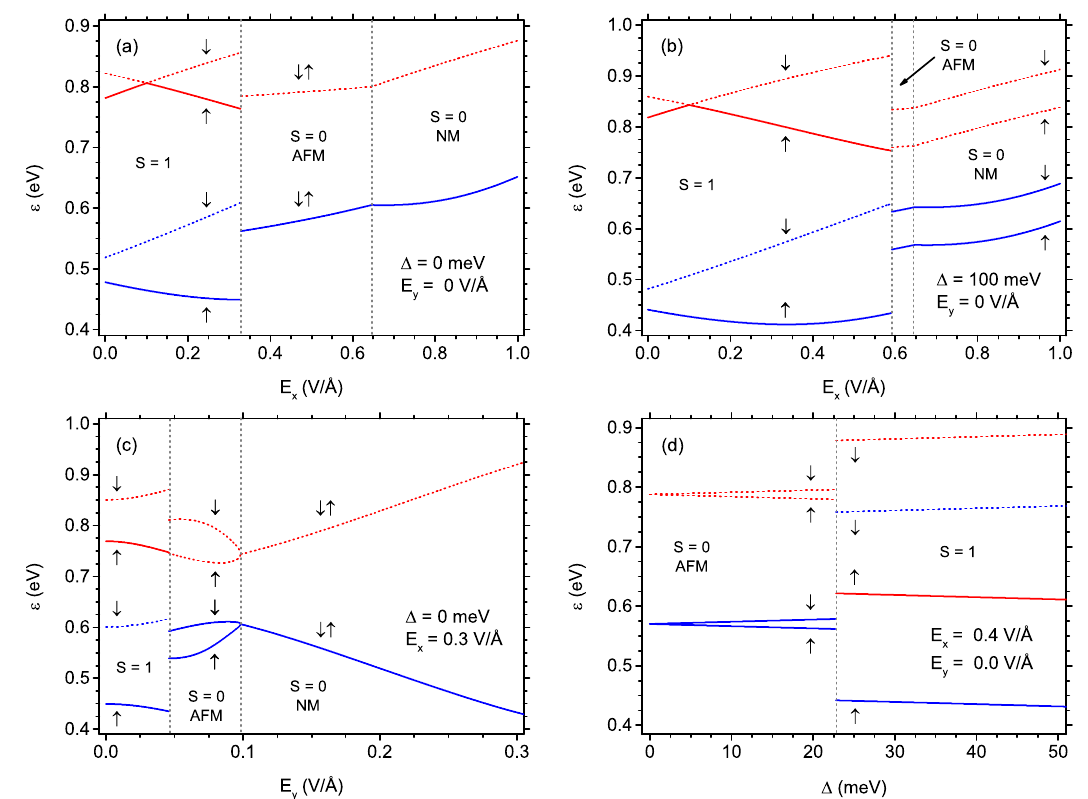
Figure 10. Single-electron eigenenergies as a function of: ( a ) electric field E x for E y = 0 and ∆ = 0; ( b ) electric field E x for E y = 0 and ∆ = 100 meV; ( c ) electric field E y for E x = 0.3 V/Å and ∆ = 0; ( d ) exchange energy ∆ for E x = 0.4 V/Å and E y = 0. Vertical dotted lines mark the points at which the state changes. The solid lines denote the states occupied by electron, while the dashed lines mark empty states. The arrows indicate the spin direction of the state. The blue color marks the lower energy and the red colour the higher energy state for the given spin orientation. Only two occupied states highest in energy and two empty states lowest in energy are